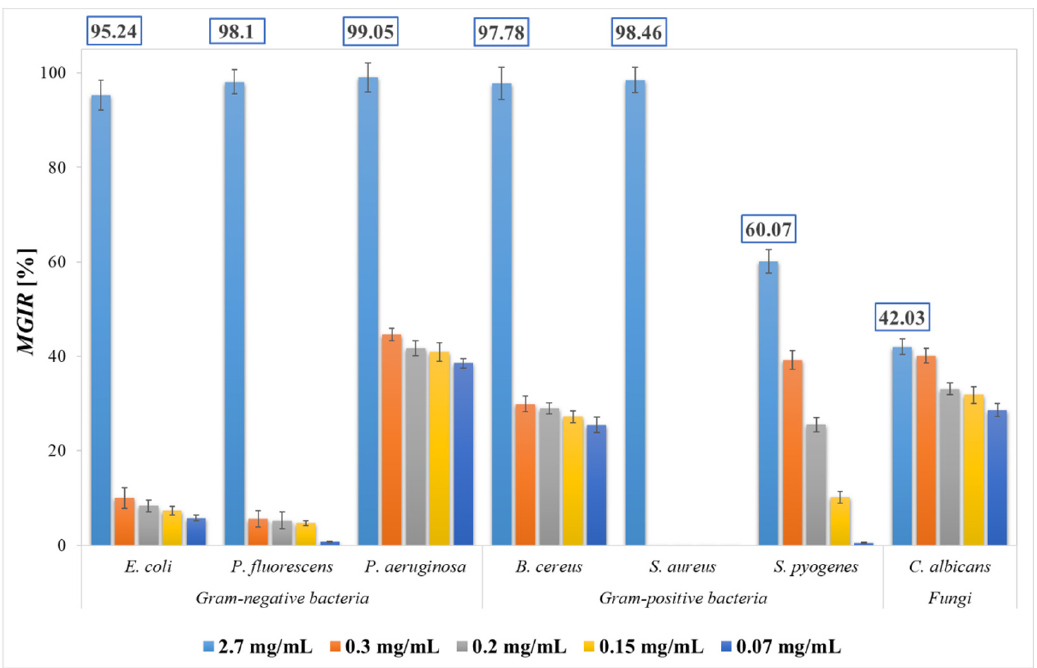
Figure 6. Microbial growth inhibition rates (MGIRs) for lyophilized PP extract obtained by super- critical fluid extraction (SFE) using CO 2 and EtOH as co-solvent at 20 MPa using 2.7, 0.3, 0.2, 0.15, and 0.07 mg sample/mL microbial suspension. Initial concentrations of bacteria and fungi were 1–5 × 10 6